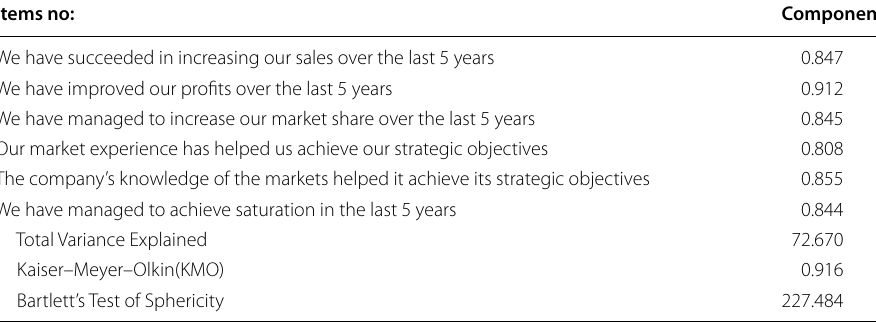
Table 5 Rotated factor for financial performance